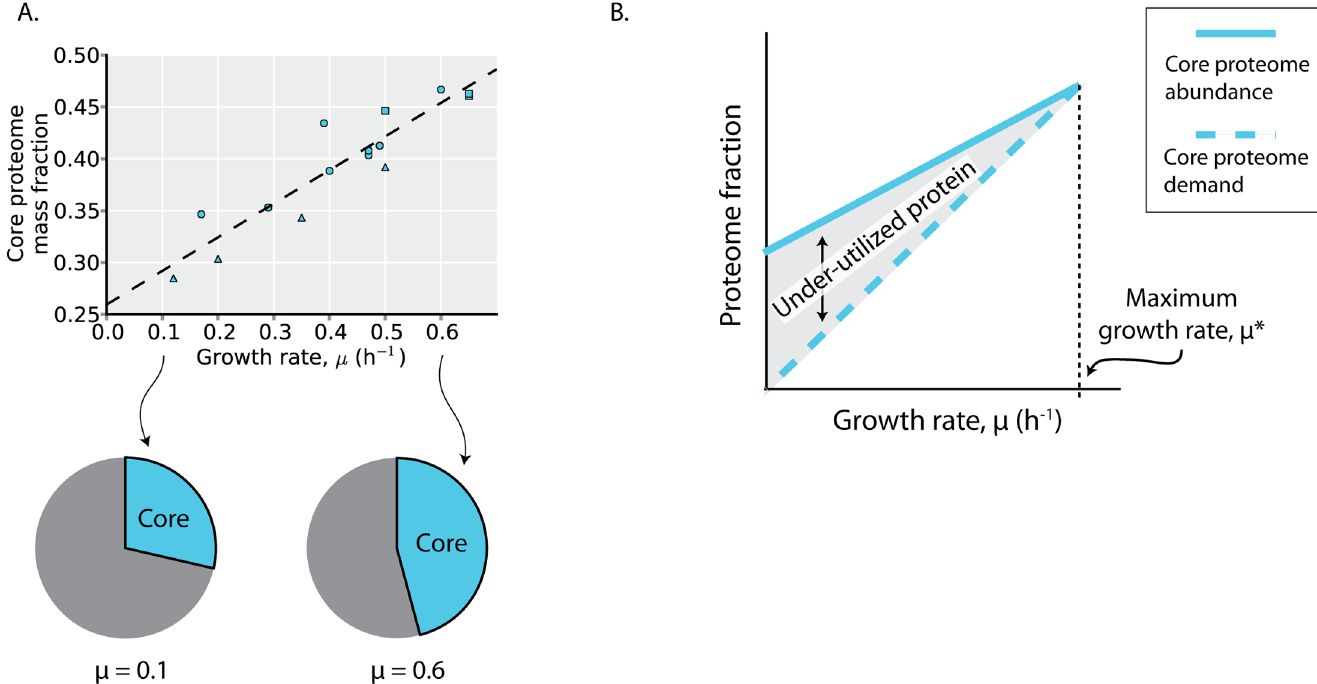
Fig 5. The core proteome is under-utilized. ( A ) The core proteome mass fraction plotted as a function of growth rate in the profiled environments. The dashed line is a linear regression (y = 0.33 x + 0.26, r 2 = 0.85, p < 10 − 5 ). Point shape indicates environment type (carbon source batch cultures = circles, glucose-limited chemostat cultures = triangles, stress conditions = squares). ( B ) Depicted is a depiction of how the expression trends of the core proteome result in under-utilized protein. The core proteome abundance (solid line) is expressed at a level above its demands for growth (dashed line) at lower growth rates, resulting in under-utilized protein and a growth rate-dependent change in in vivo enzyme activity (Fig 1D). These growth rate- dependent changes have been experimentally demonstrated for ribosomal proteins [13,14].